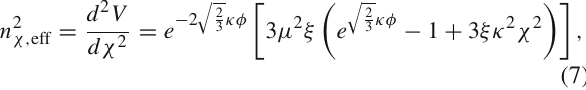
the Lagrangian in the Einstein